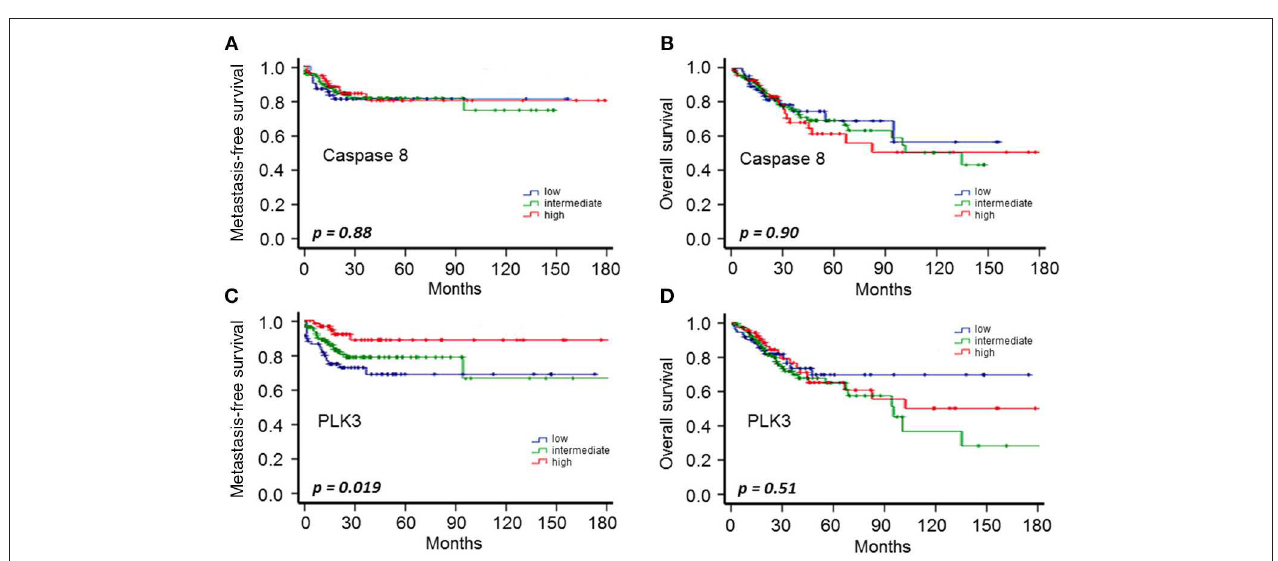
FIGURE 3 | Cumulative incidence of local (A) and distant failure (B) , CSS (C) and OS (D) according to T273 Caspase 8 phosphorylation (low: individual WS ≤ median; high: individual WS > median) in patients with CSCC treated with definitive CRT and BT.